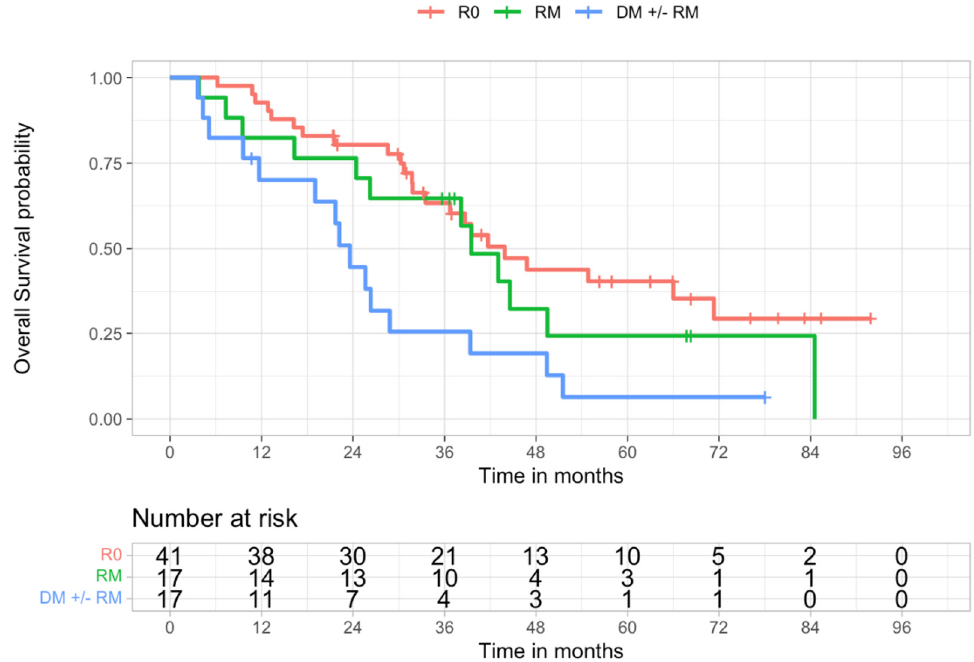
Figure 2. Kaplan-Meier overall survival curves of R0, RM, and DM ± RM populations (log-rank test, p = 0.0056).